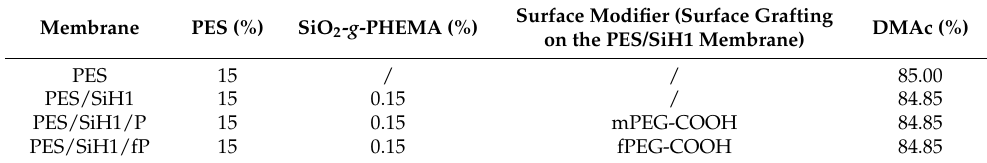
Table 1. The compositions of the casting